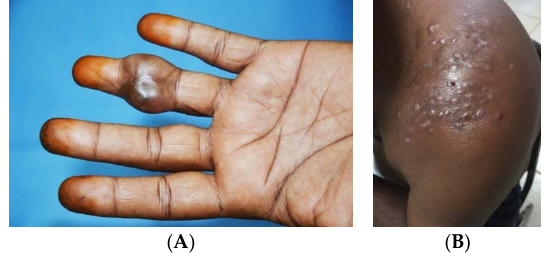
Figure 1. ( A ) A small mycetoma swelling engulfing the middle part of the left ring finger with a scar of previous surgical excision. ( B ) Multiple small nodules of Nocardia actinomycetoma at an earlier